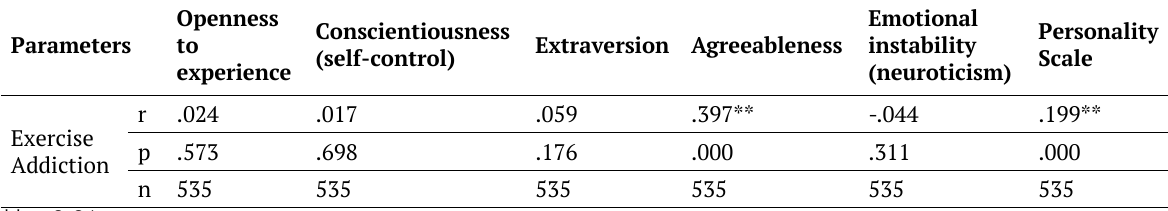
Table 6. Correlation table between personality and exercise addiction